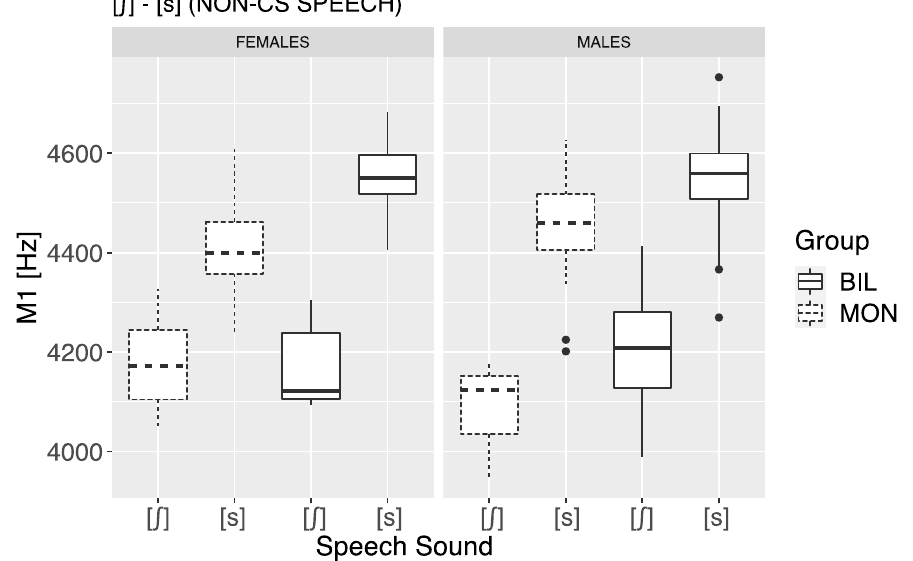
Figure 9. The first spectral moment of intended [ ʃ ] and [s] sounds in English words in non-CS environments, spoken by the MON speakers (dashed), and by a selection of BIL speakers (solid), who have been shown to have shifted CS [s] away from non-CS [s]. The left panel shows female data, the right panel male data.